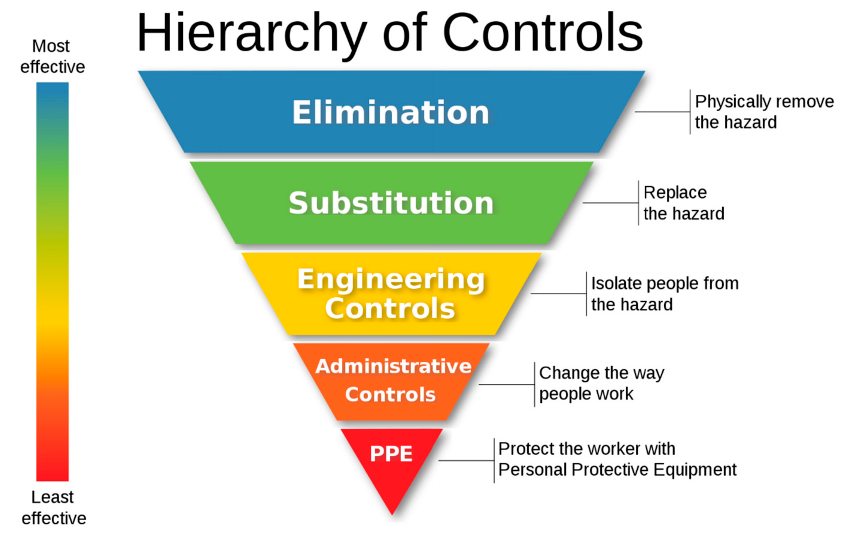
Figure 2. The hierarchy of controls for occupational hazards. Copyright: public domain [42]. Table 1. Adapting the hierarchy of controls to extended shifts.